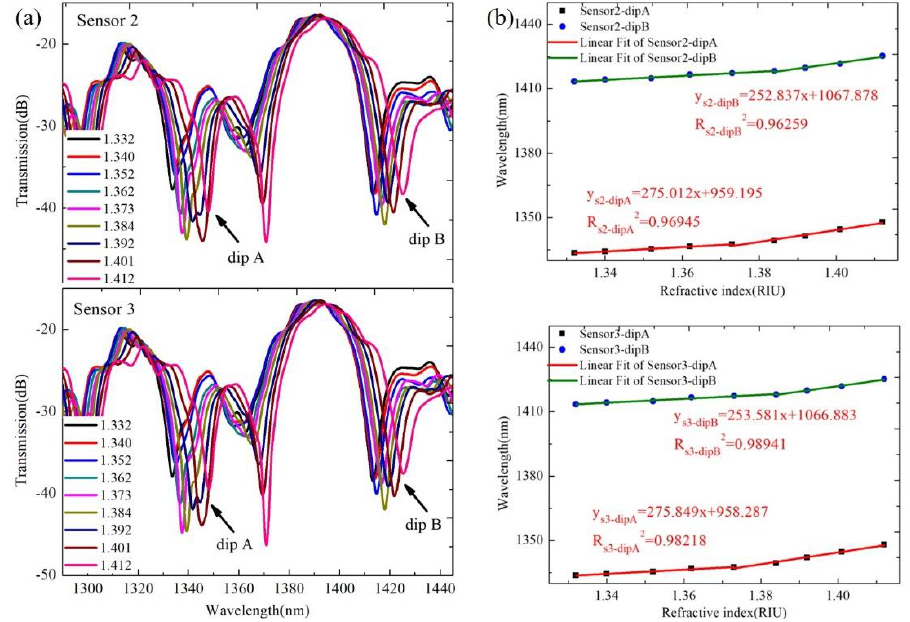
Figure 9. ( a ) The interference spectra of Sensor 2 and Sensor 3 at different RI; ( b ) the wavelength shift trends for Sensor 2 and Sensor 3 under different RI.